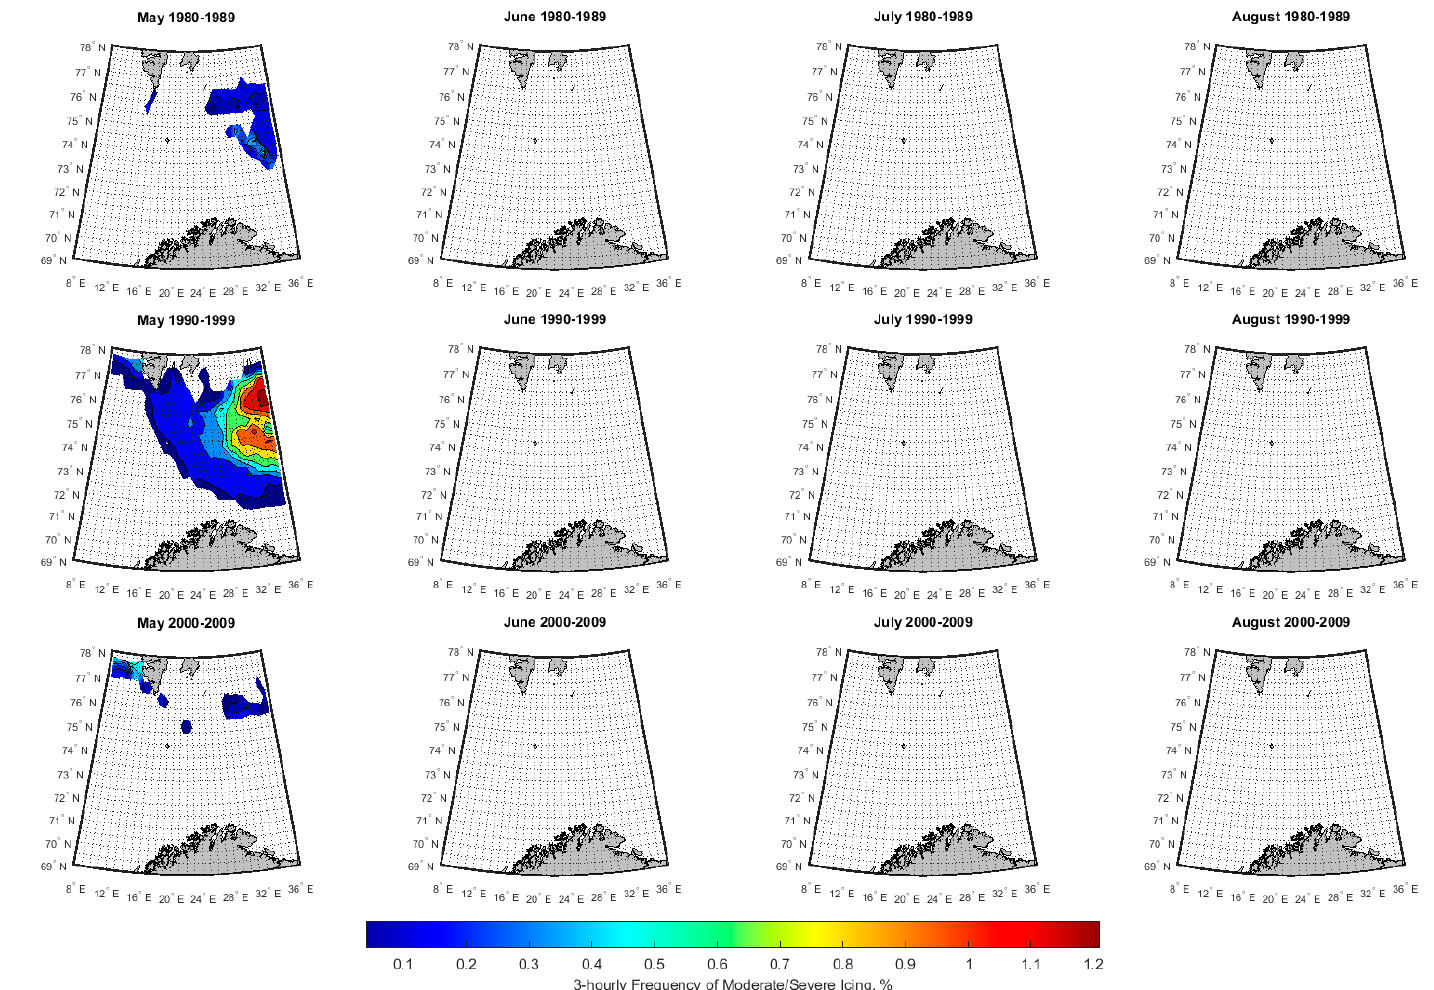
Figure 17. Three-hourly frequency of moderate and severe icing events in each region during the 1980s, 1990s, and 2000s (May, Jun, Jul, Aug).